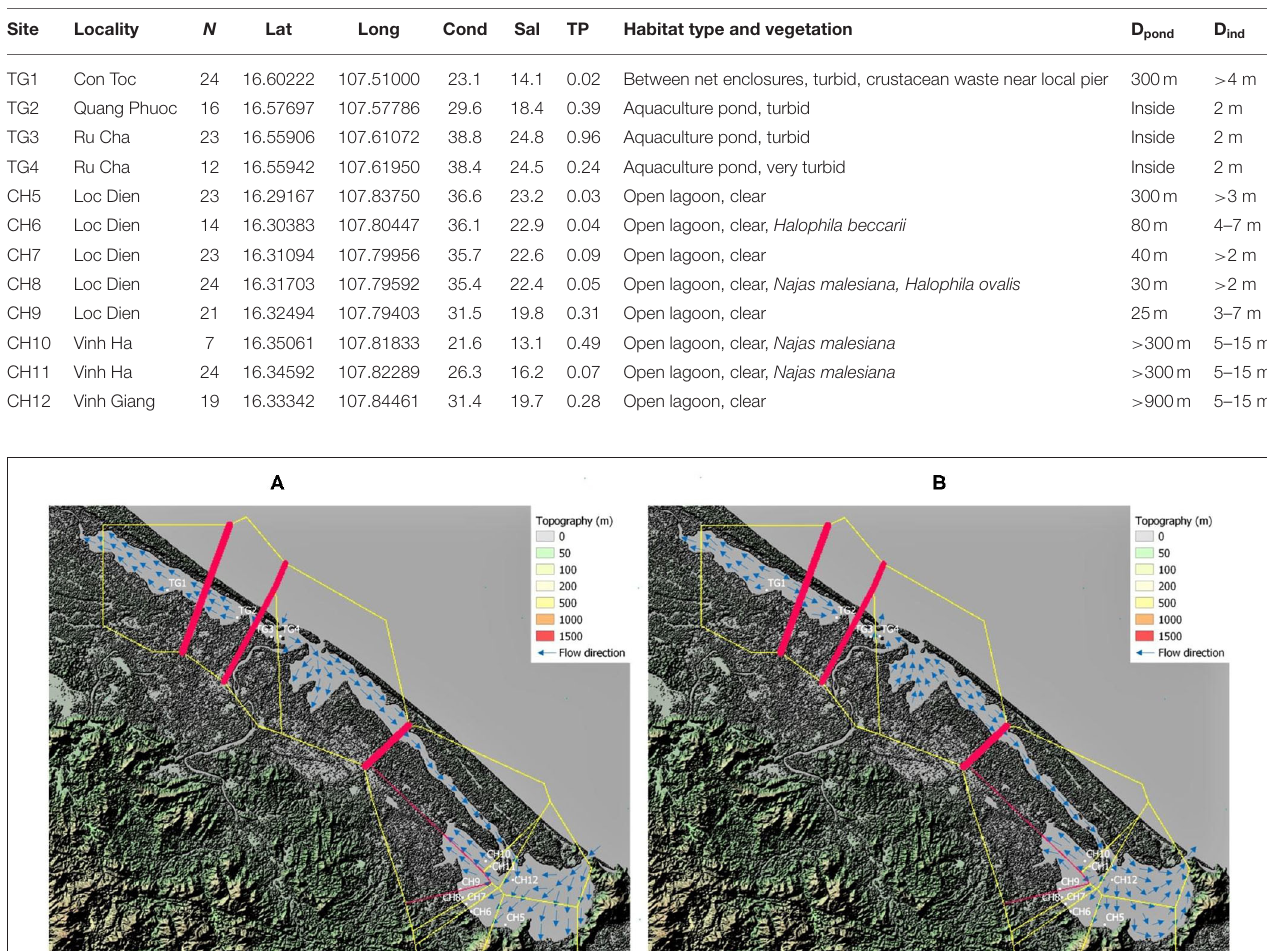
based on fragment length and number of repeats. We